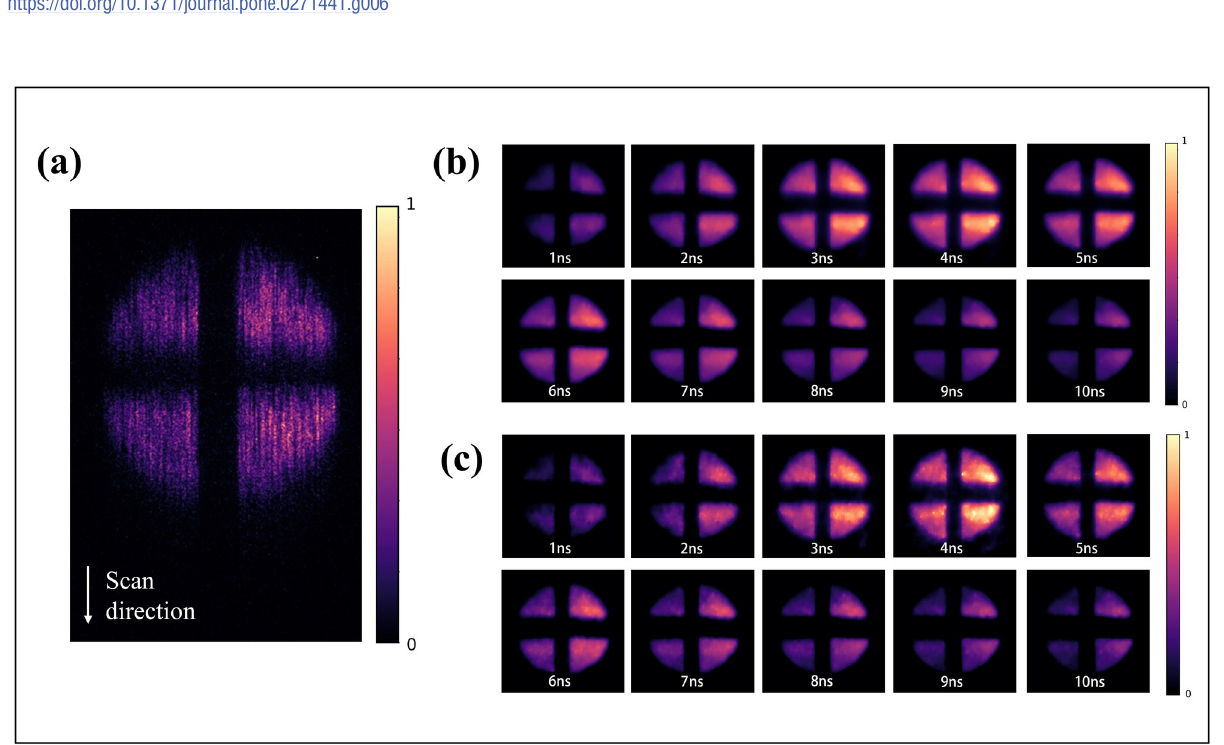
Fig 7. Measurement and reconstruction data of Rhodamine B: (a) Streak Camera image; (b) Reconstructed frames using PnP-TV+FFDNet algorithm; (c) Reconstructed frames using PnP-3 DTG p V_net algorithm.